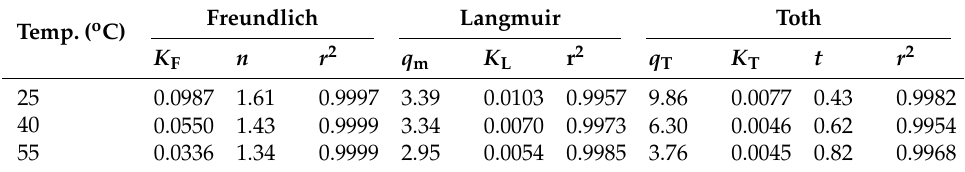
Table 5. Fitted parameters of three isotherm equations for CO 2 adsorption on CN2/ACF. Temp. ( o C)